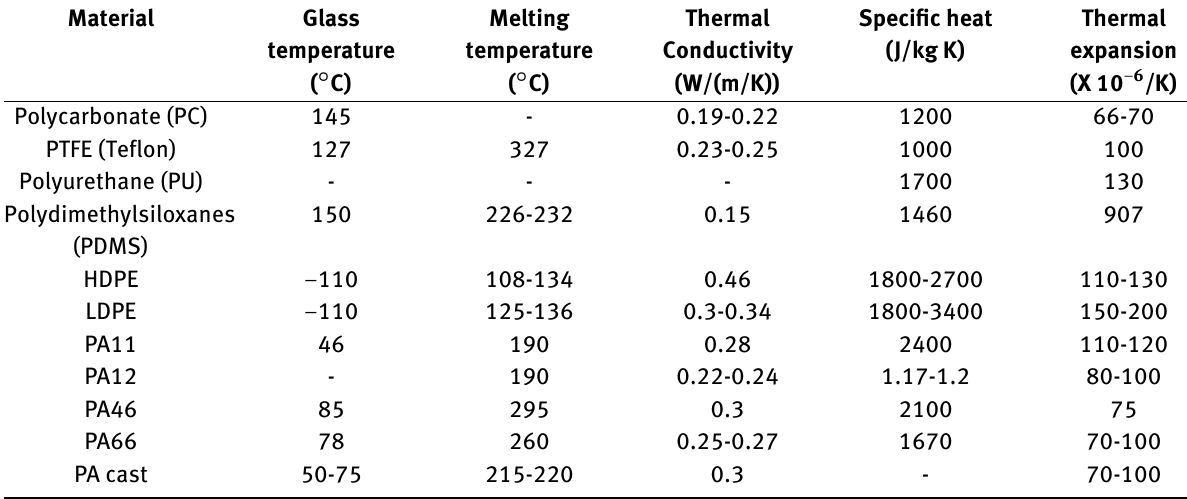
Table 6: Comparison of thermal properties of typical polymers used in artificial hearts [92, 95].